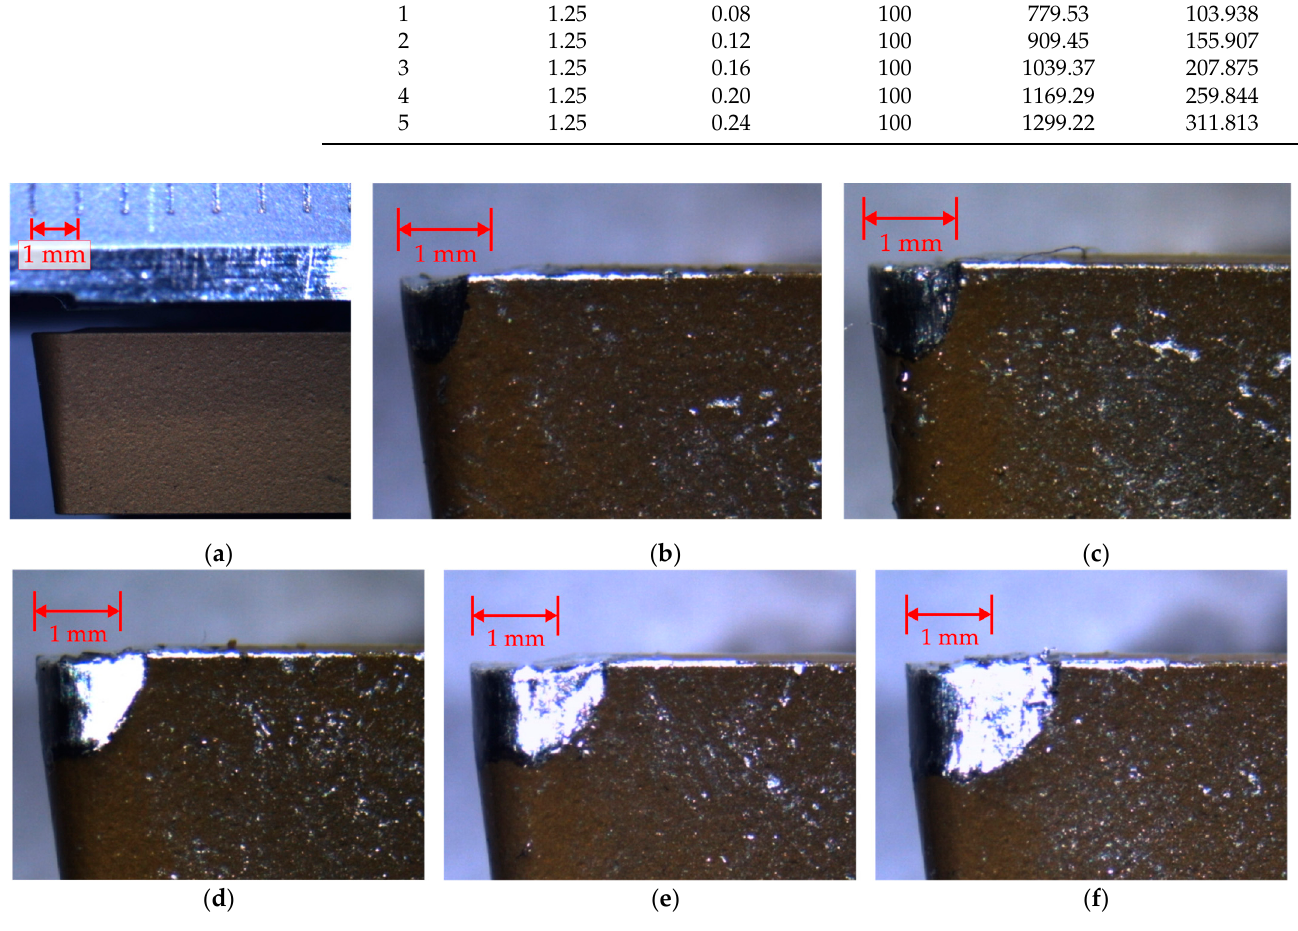
Figure 9. Cutting tools used for the tool feed rate experiments: ( a ) CT-f0; ( b ) CT-f1; ( c ) CT-f2; ( d ) CT- f3; ( e ) CT-f4; ( f )